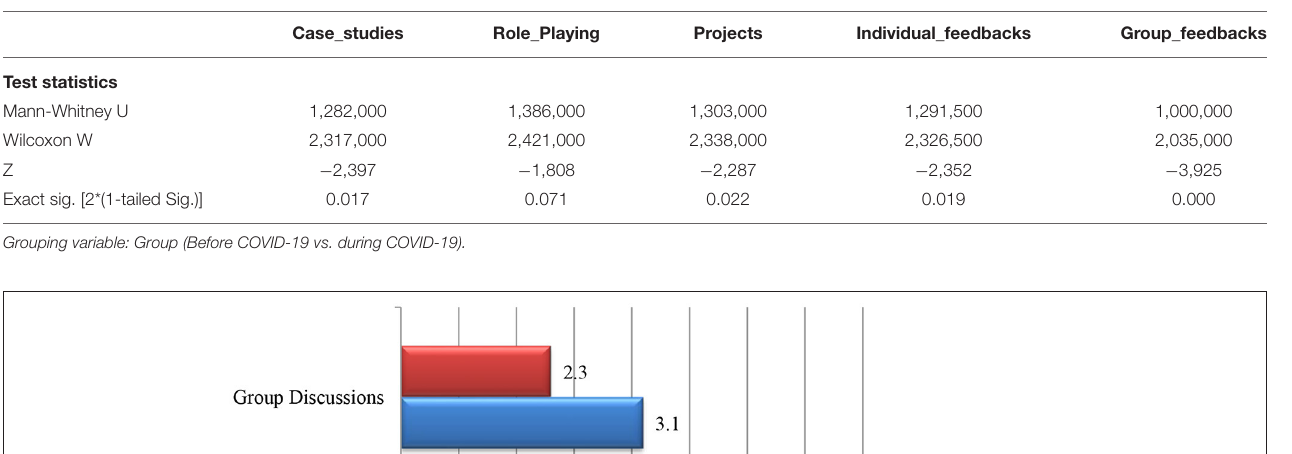
TABLE 2 | The results of the Mann-Whitney U test.